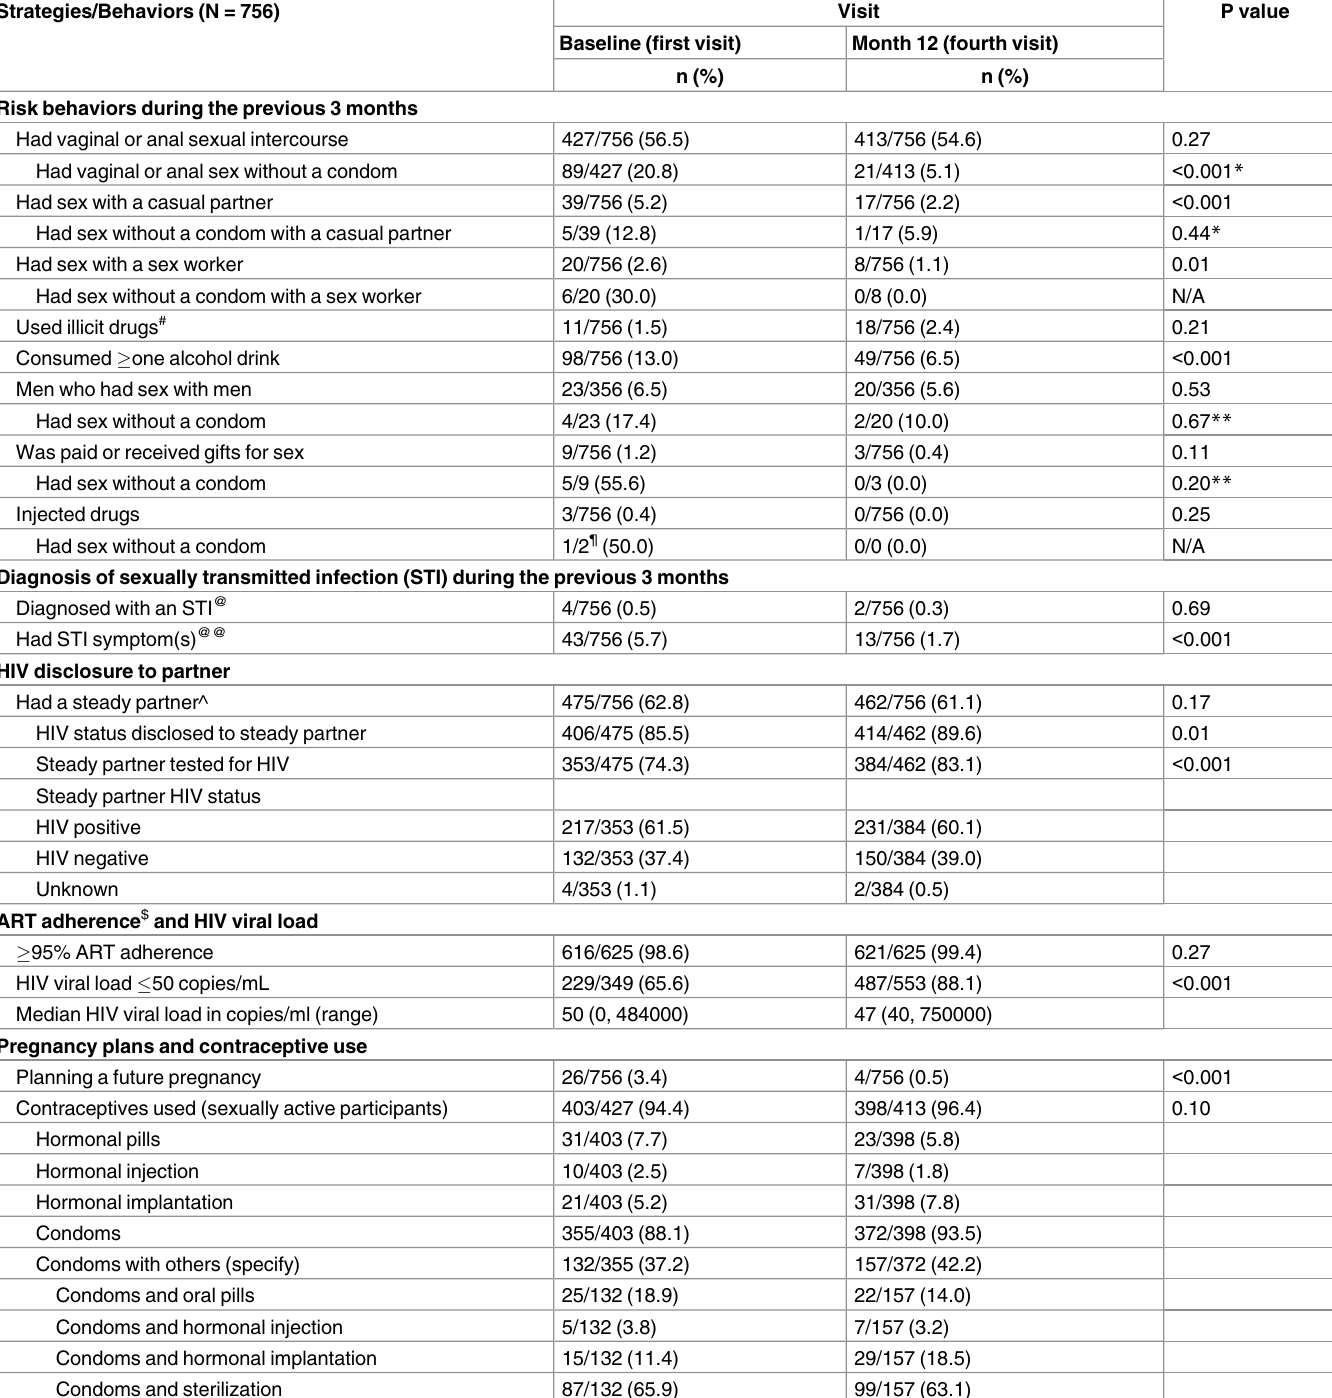
Table 3. Risk behaviors reported by people living with HIV participating in the prevention with positives intervention assessment, Thailand, 2008–